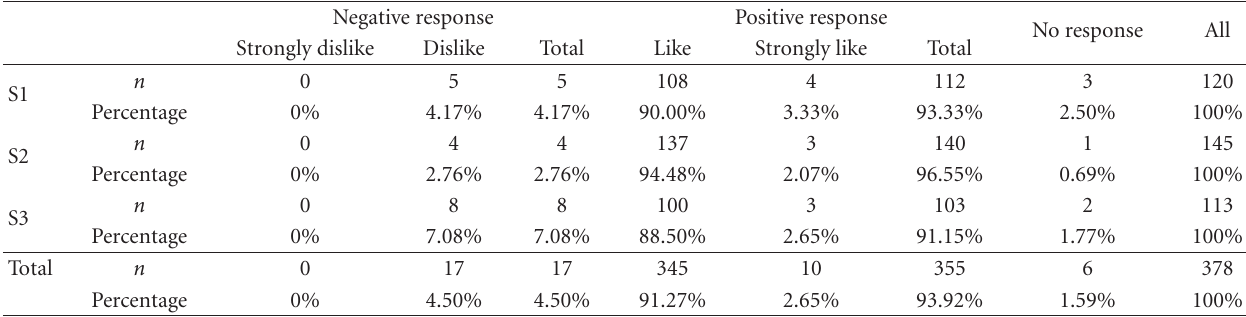
Table 3: Degree of students’ liking of the program perceived by the program implementers.